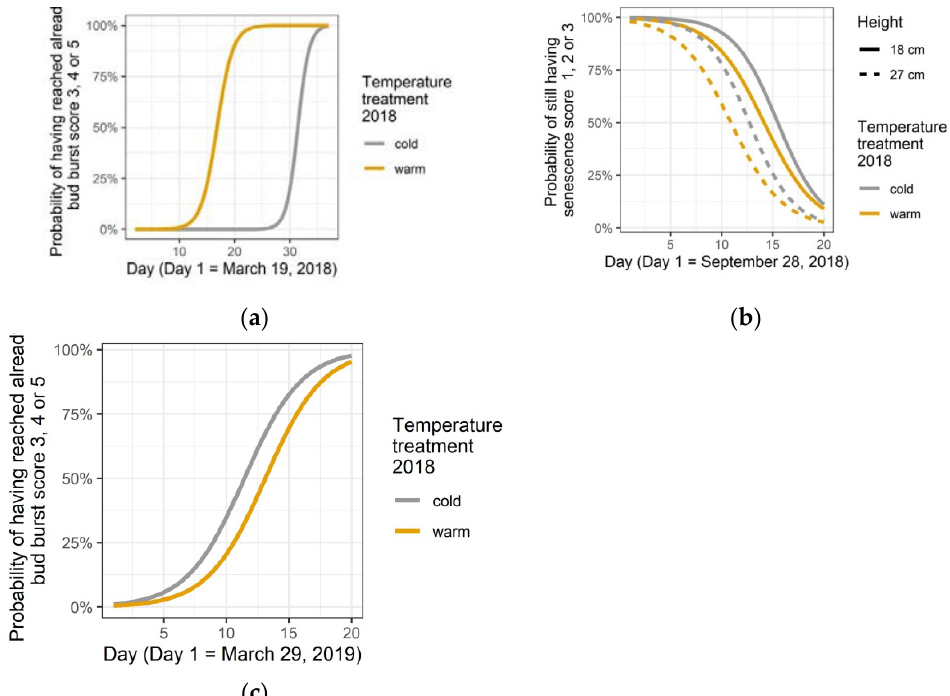
Figure 5. Modelled probabilities of having reached the given score levels for bud burst in 2018 ( a ), for leaf senescence in 2018 ( b ) and for bud burst in 2019 ( c ). The probabilities depend on the temperature treatment in the spring of 2018. Leaf senescence additionally depends on the height of the plants (model fit shown for lower and upper quartiles).